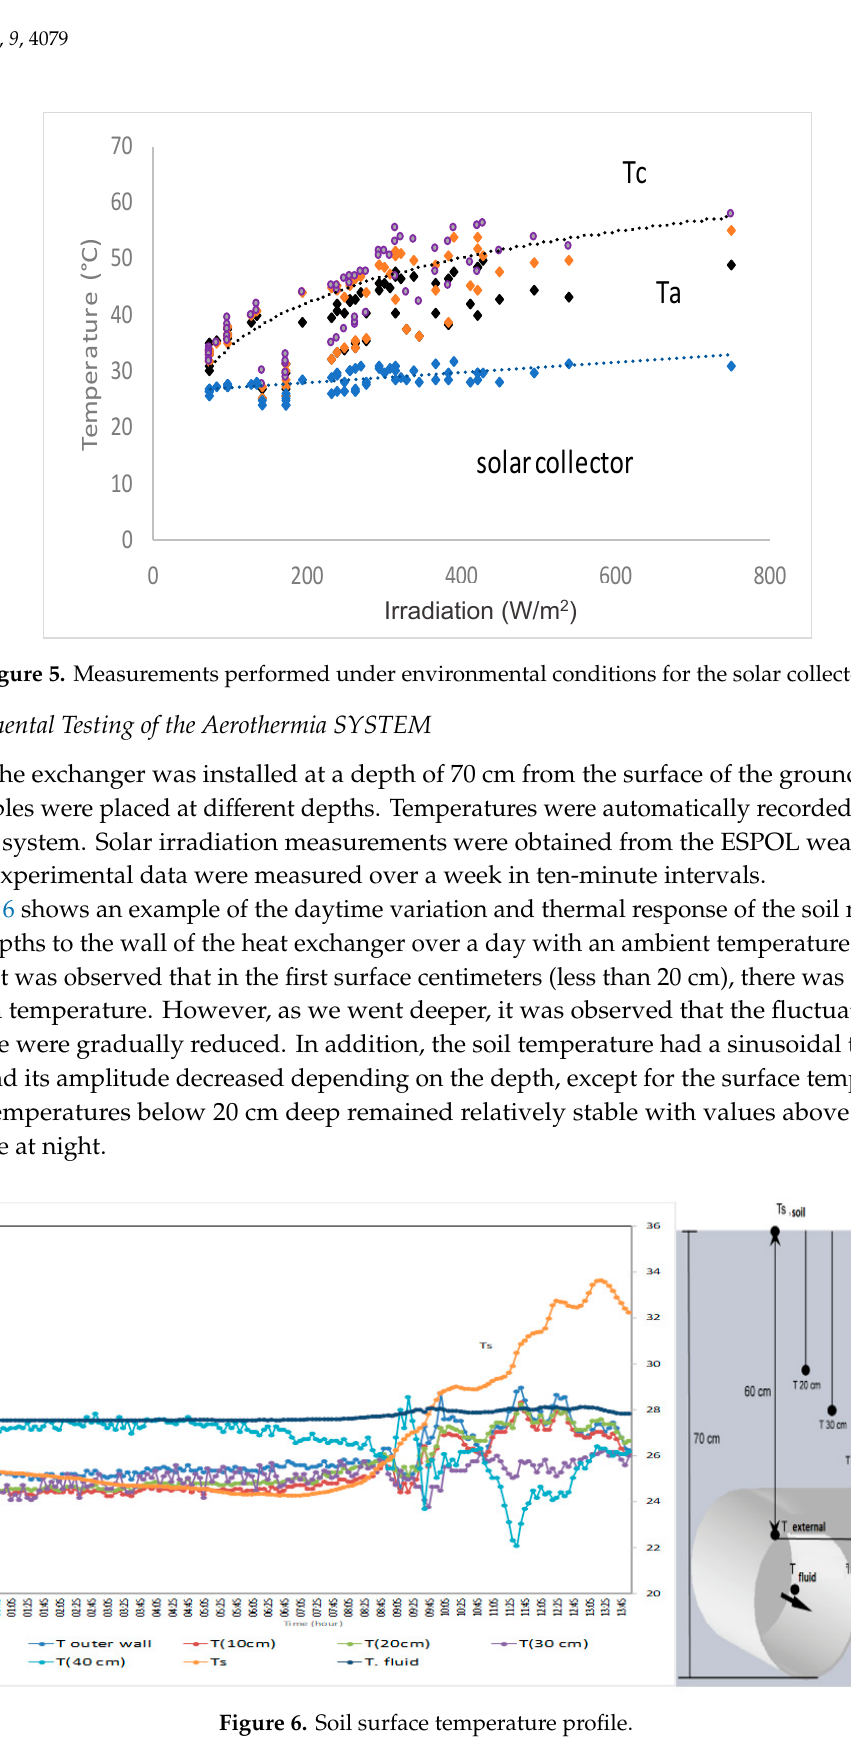
Figure 4. Measurements performed under environmental conditions for the solar dryer.